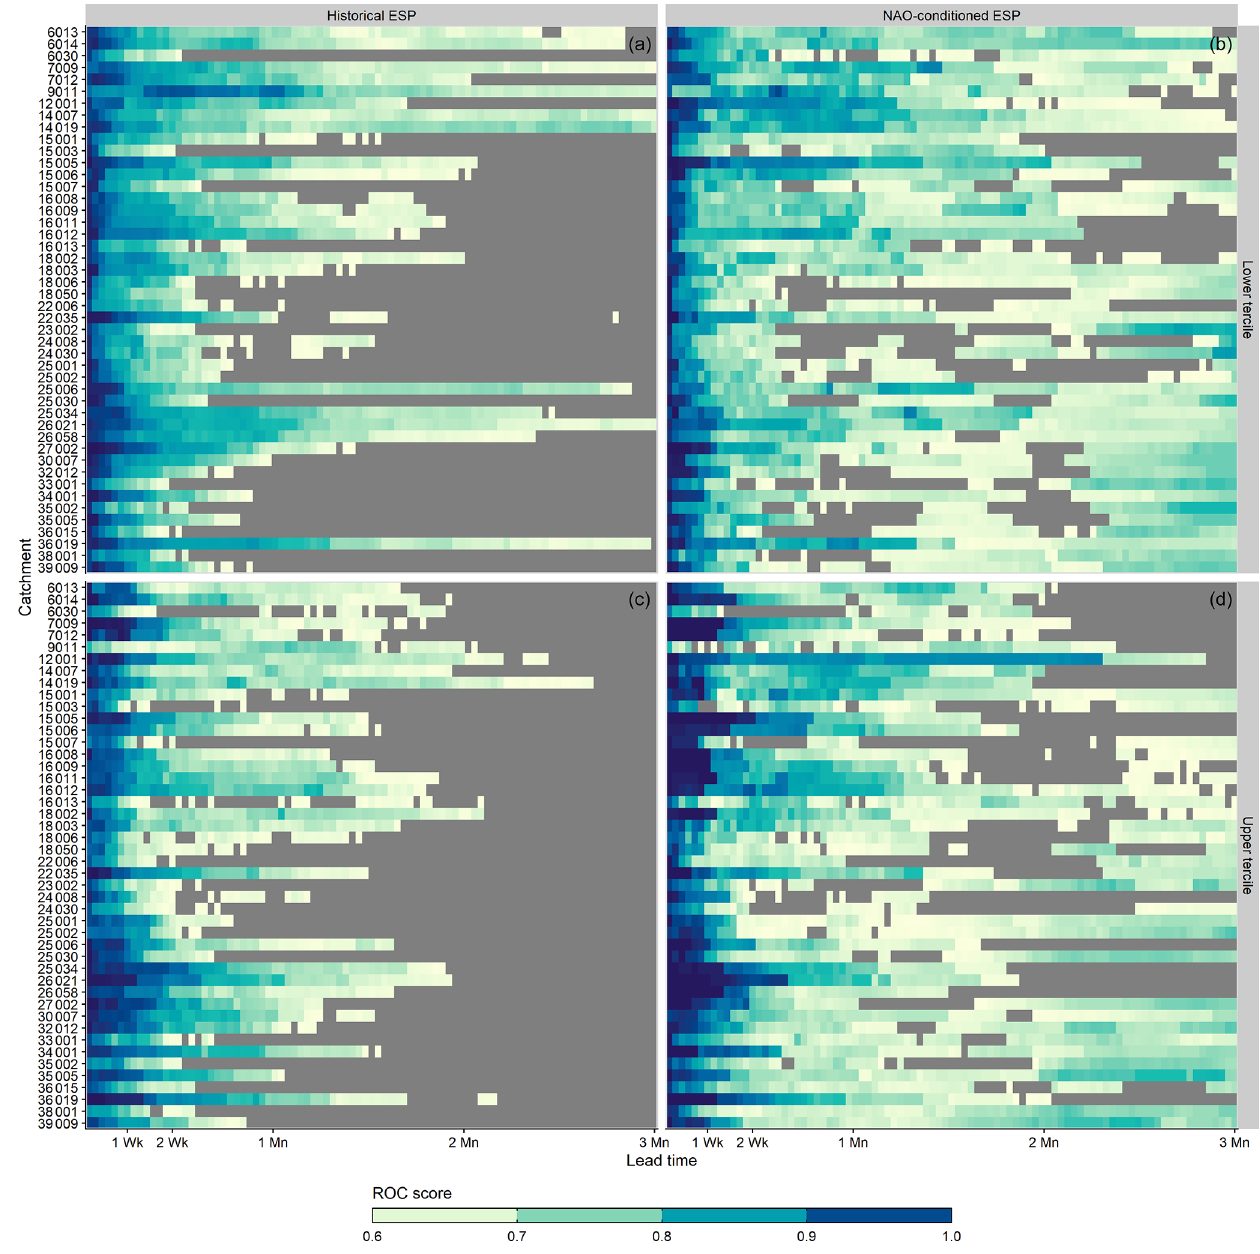
Figure 12. Comparison of ROC scores achieved by historical ESP (a, c) and NAO-conditioned ESP (b, d) across all 46 study catchments and all lead times for low-flow (lower tercile, a, b ) and high-flow (upper tercile, c, d ) events. Cells with no skill (ROC < 0.6) are greyed out.